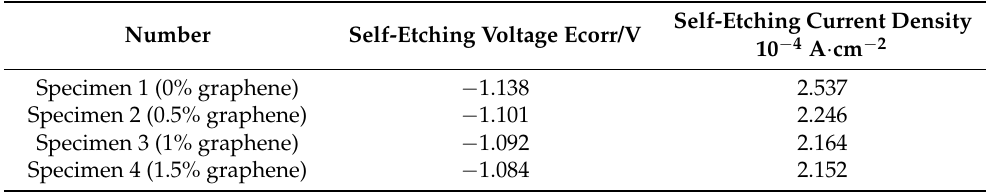
Table 5. Self-corrosion voltage and self-corrosion current density of the cladding